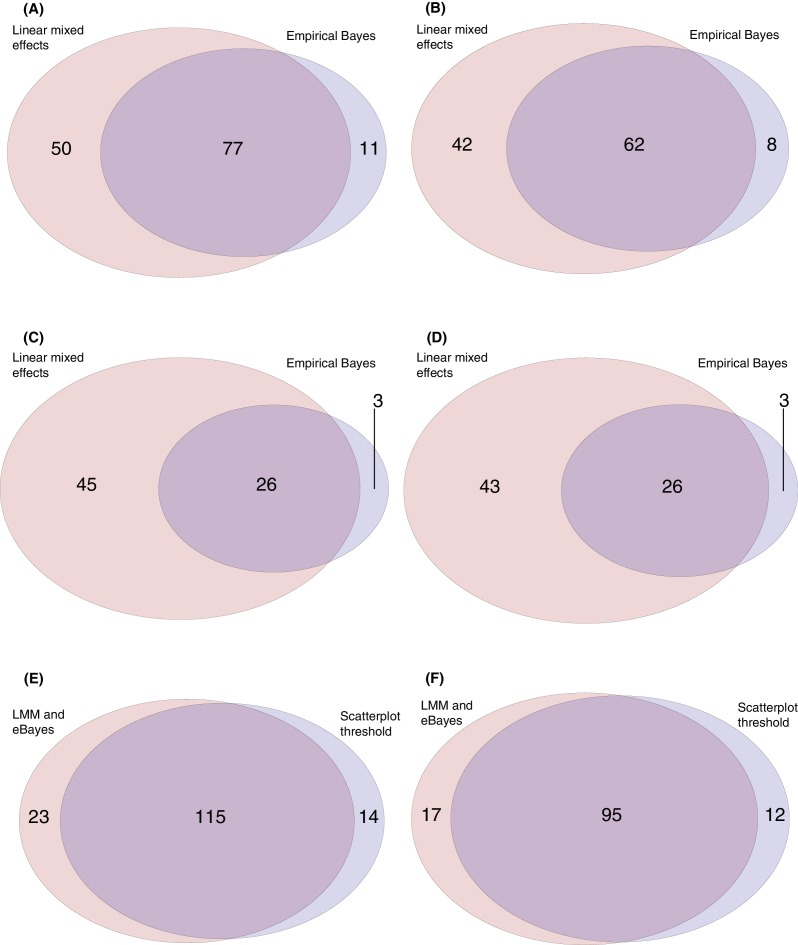
Venn diagrams comparing the results of the empirical Bayes analysis, linear mixed effects models, and empirically-derived threshold applied to theΔ0→84 values shown on the scatterplots in Figure 3.The threshold approach, and empirical Bayes model, were applied to identify the array probes to which elevated IgG responses were evident between the first and final timepoints for the 29 individuals for whom these data were available. The linear mixed effects model was applied to identify the probes to which there was an increasing IgG response across the four timepoints for the 20 individuals in vaccinated cohorts for whom a complete set of longitudinal samples were available. (A) This Venn diagram shows the linear mixed effects model identified a greater number of probes (127) than the empirical Bayes analysis (88), but the majority of probes identified by either method were consistent with the other. (B) This Venn diagram combines probes corresponding to different parts of the same protein into single datapoints. This shows relatively few proteins were only supported by one of the two methods. Panels (C) and (D) show the same comparisons for the analyses excluding the DCL probes. For panels (E) and (F), the 138 probes identified by either the linear mixed effects models or empirical Bayes analyses were compared against the 129 probes identified as exceeding the threshold Δ0→84 value of 0.2 in cohort 3 (Figure 3D). (C) This Venn diagram shows the model fitting results are highly consistent with those from the threshold-based approach. (D) This Venn diagram combines probes corresponding to different parts of the same protein into single datapoints, showing the results are similar as to panel (C).